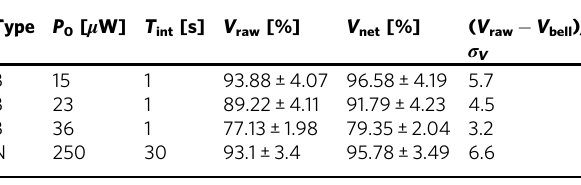
Table 1 Time-energy entanglement for different effective pump powers.